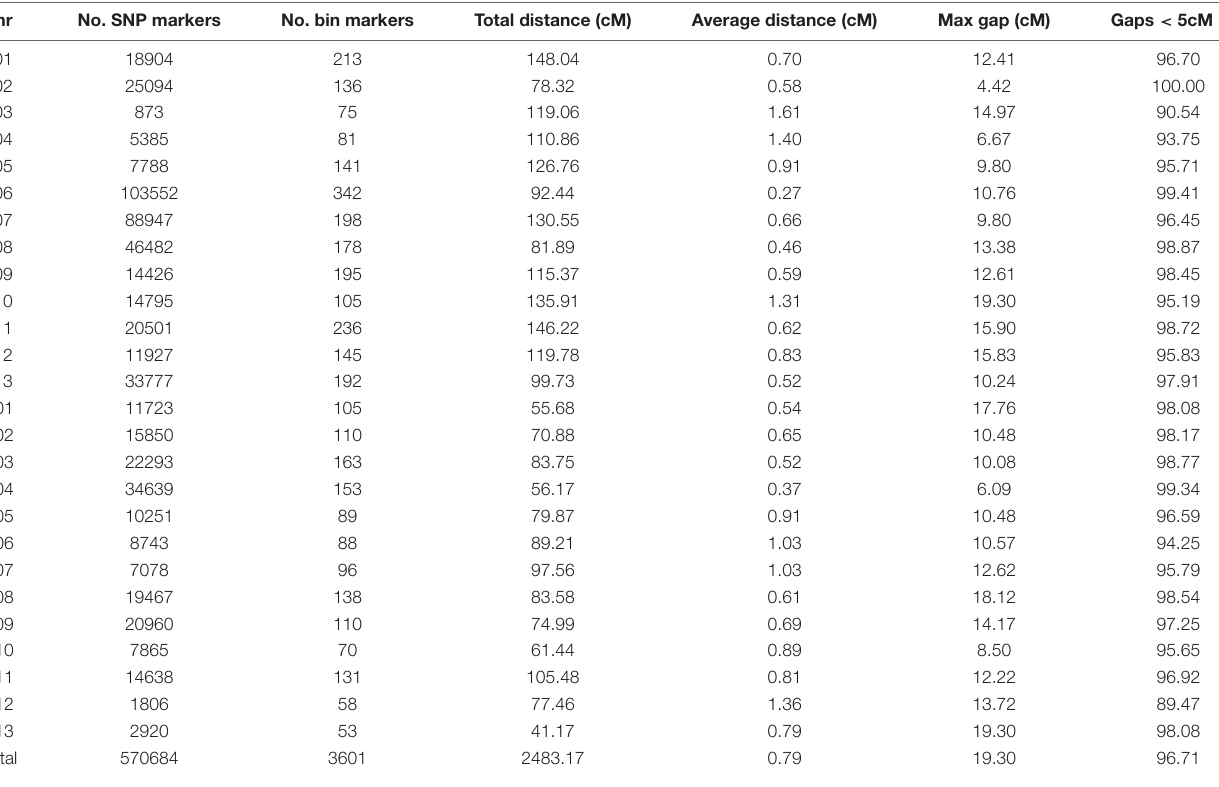
TABLE 3 | Detailed information on the SNP markers in the genetic